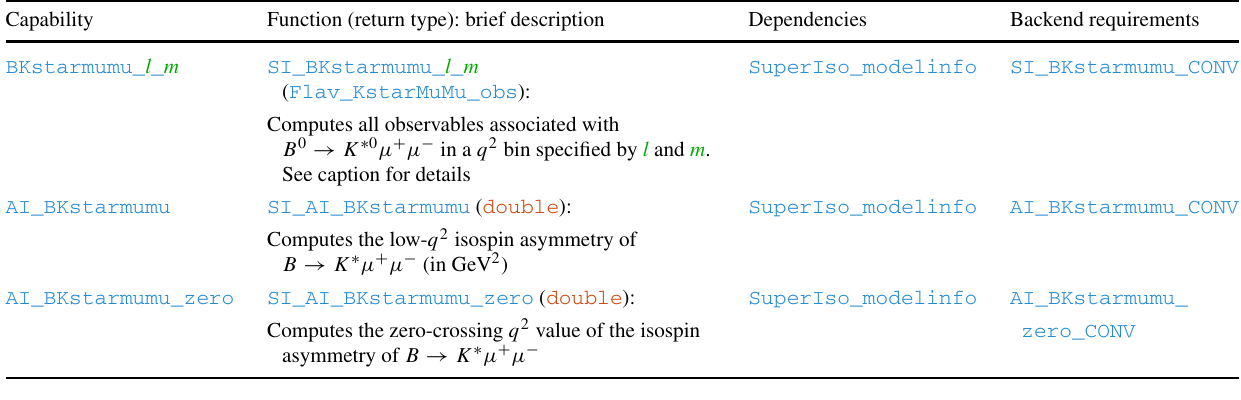
Table 3 Observable capabilities of FlavBit related to the decay B 0 → K ∗ 0 μ + μ − . The indices l and m refer to the edges of the energy bin used intheparticularfunction.Thefunctionsandcapabilitiesarenamedsuch that l , m = 11,25 indicates an energy range of 1 . 1–2 . 5 GeV 2 , and so on.